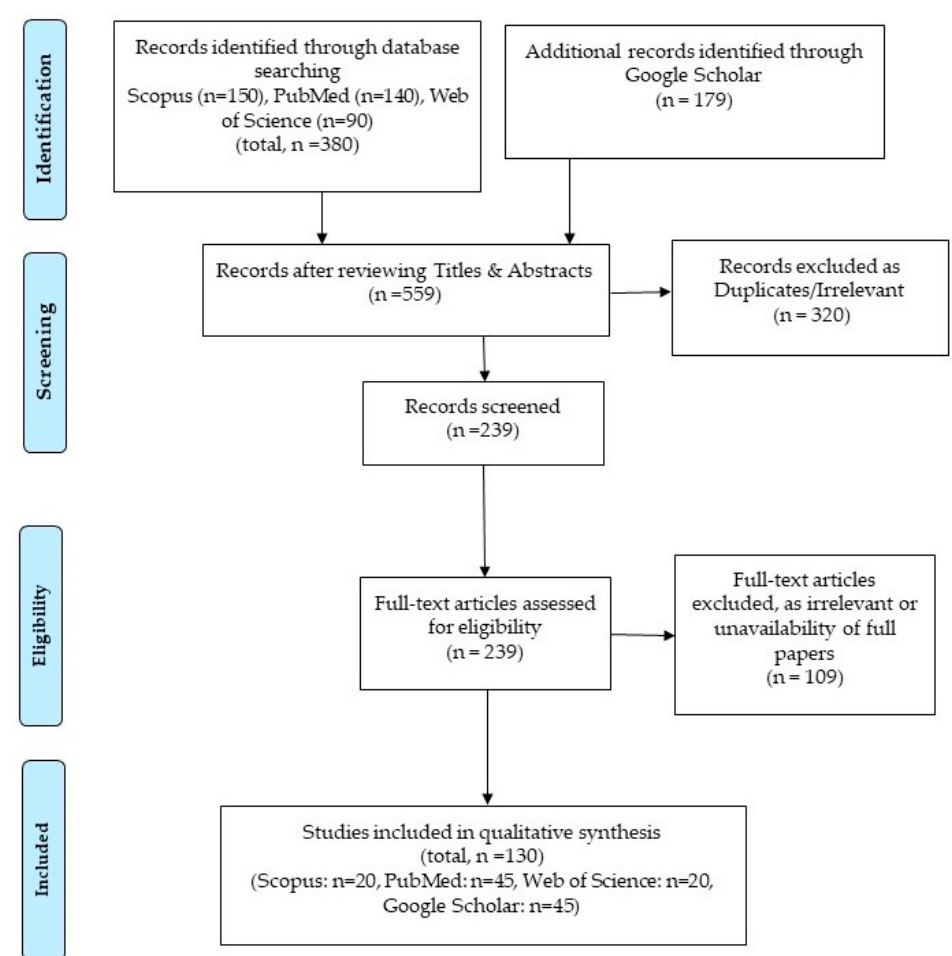
Figure 1. Process for selecting studies included in this review using PRISMA guidelines [40].